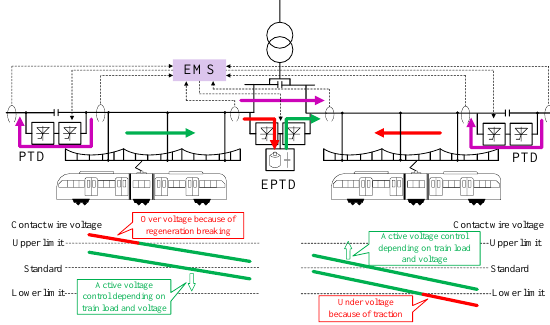
Figure 8. Active voltage control based on the modified system.